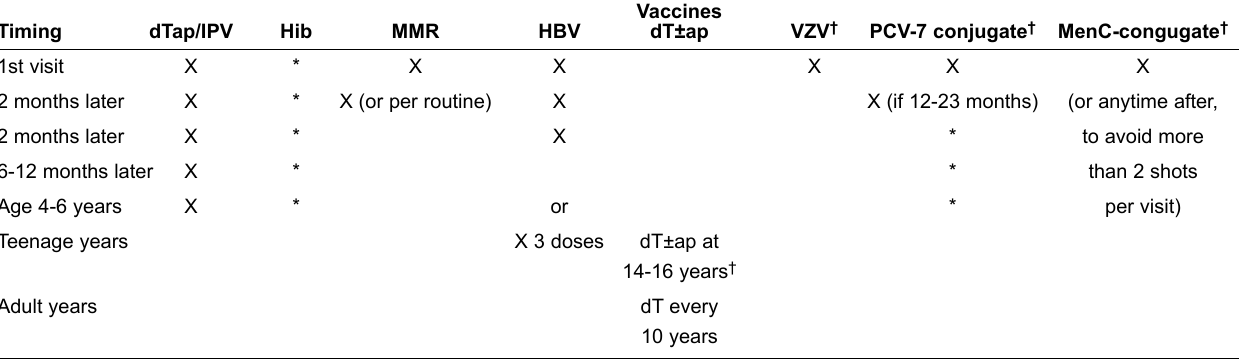
Immunization schedule for children one to six years not previously immunized in infancy (and still nonimmune)